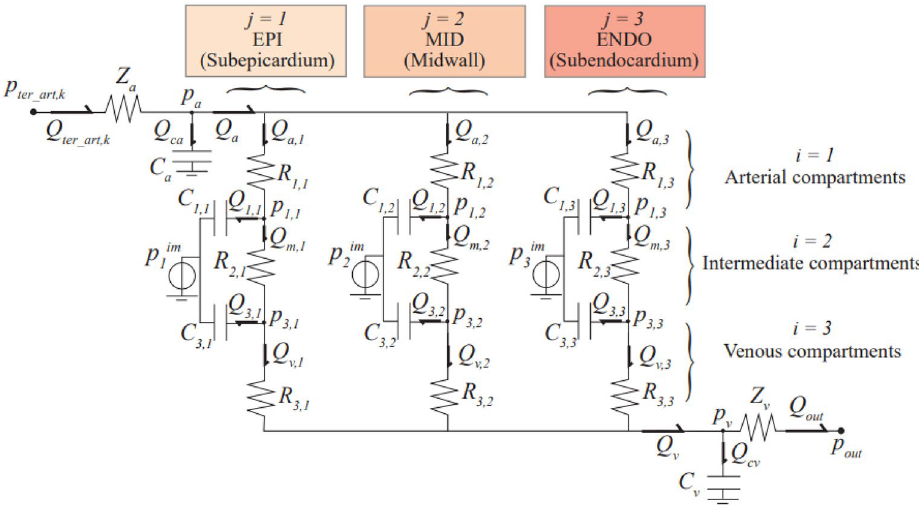
Figure 2. The 0D lumped parameter circuital scheme of a k th generic coronary distal circulation and microvasculature. The scheme allows for the subdivision among myocardial layers (index j ) and compartments (index i ). Acronyms EPI , MID and ENDO stand for subepicardium, midwall and subendocardium, respectively, whereas an arterial, an intermediate and a venous compartment may be identified. Z ca and Z cv represent input and output impedances of each district, R i,j and C i,j are the resistance and compliance parameter assigned to each i -th compartment belonging to the j -th layer, and p j im is the external forcing intra-myocardial pressure. Q ter_art,k , Q out , Q a , Q v , Q ca , Q cv , Q ja , Q jm , Q jv , Q ij , p ter_art,k , p out , p a , p v and p ij are the hemodynamic variables associated with each single branch or node of the considered coronary